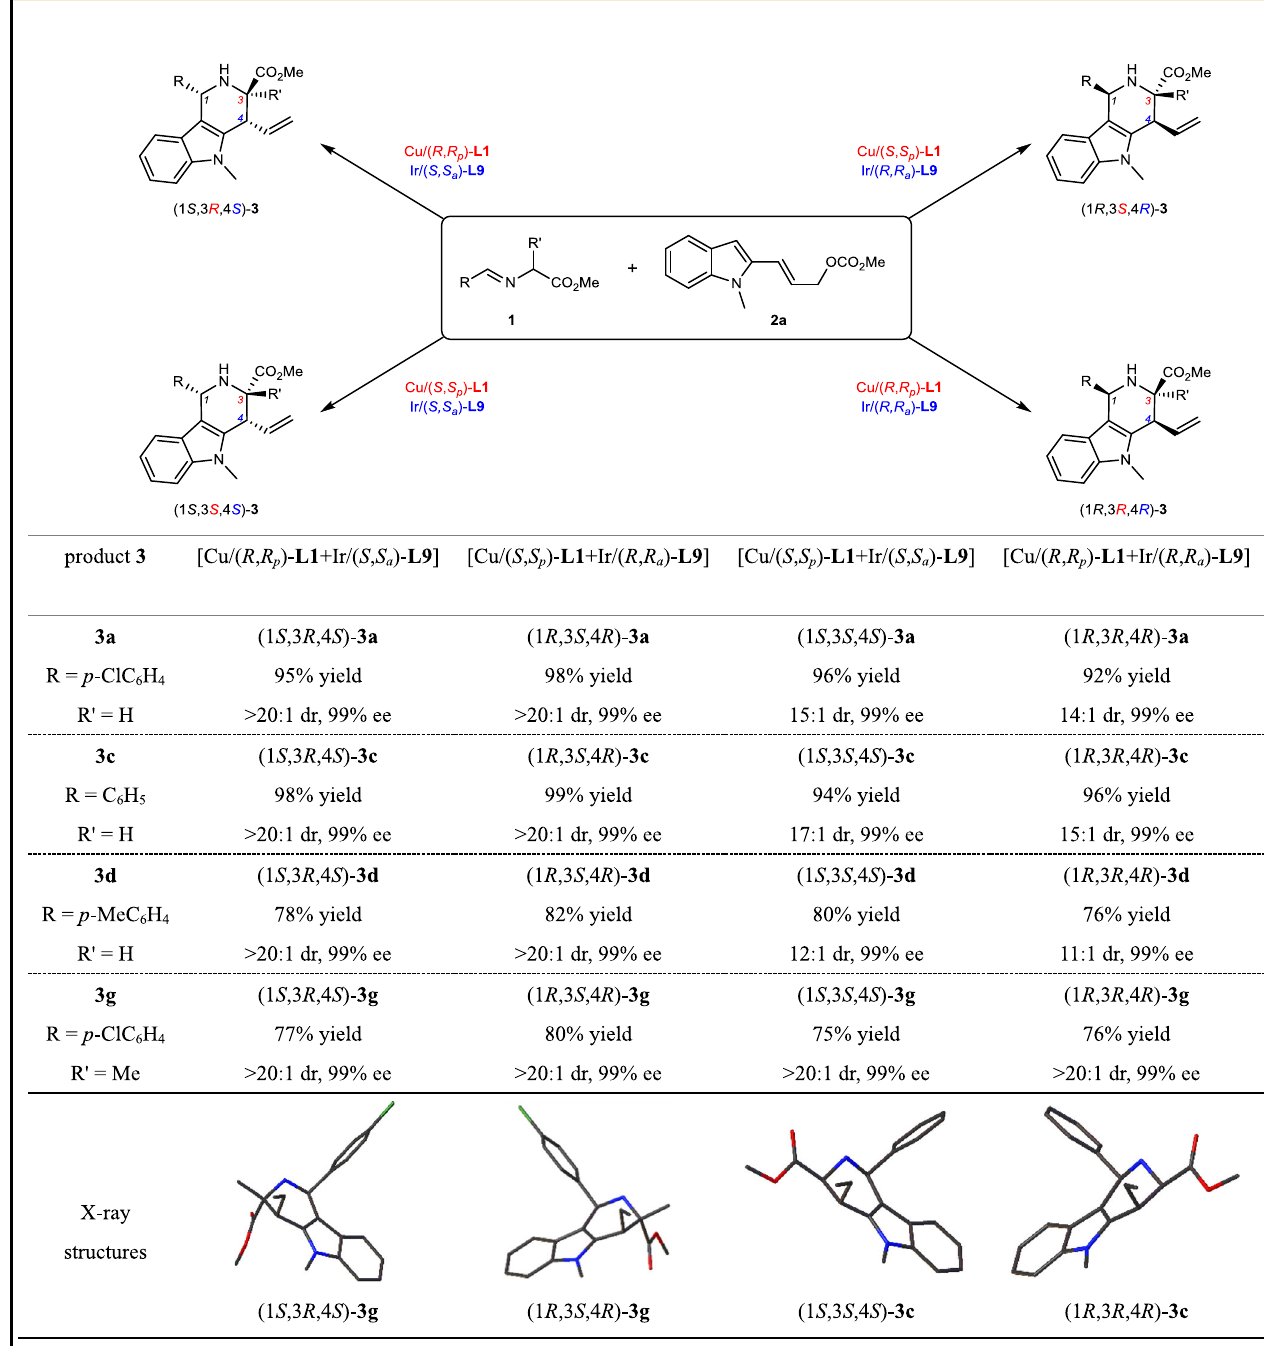
Table 4 Representative examples of stereodivergent synthesis of four stereoisomers from reaction of 2-indolyl allyl carbonates with aldimine esters a